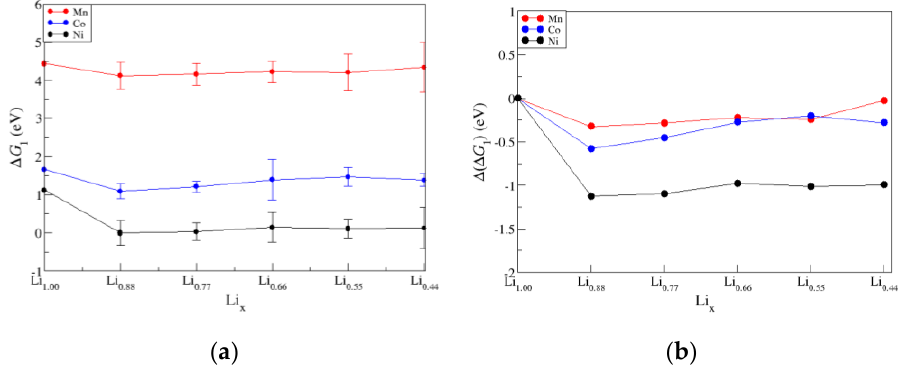
Figure 4. ( a ) Δ G 1 changes for Ni (black), Co (blue), and Mn (red) with respect to lithiation state. Δ G 1 values are plotted with the lowest Δ G 1 value referenced to zero and σ is shown with error bars. ( b ) To observe how much each metal changes individually, the initial M − OH.